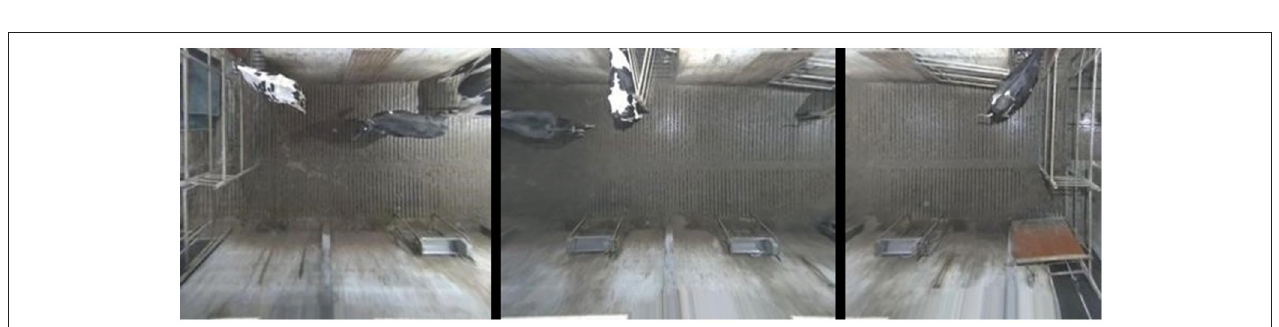
FIGURE 3 | Dewarped frames from each of the cameras with overlaps to allow the detector to process them one by one.